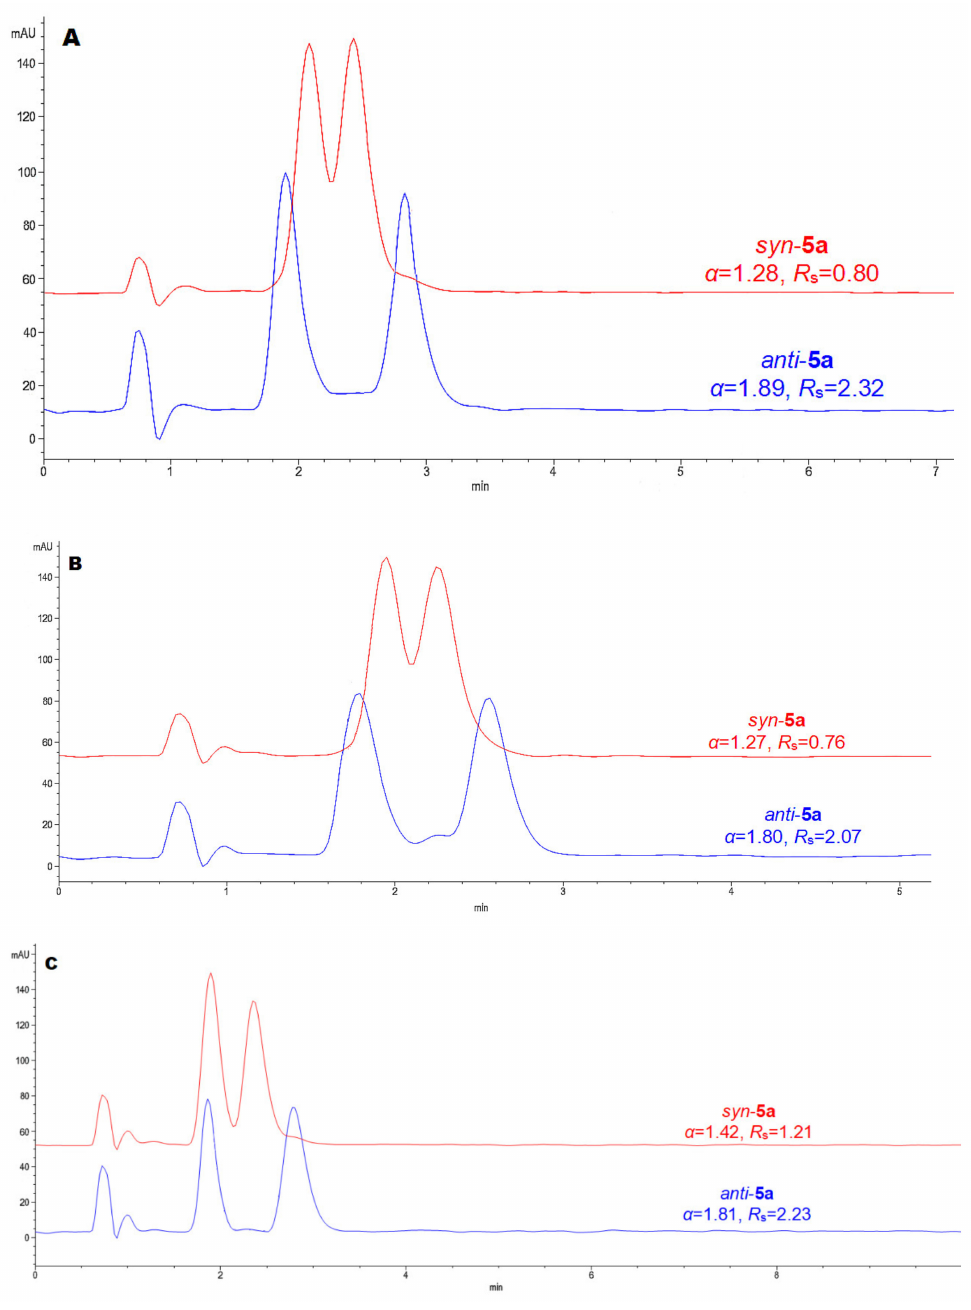
Figure 6. SFC overlay chromatograms of ( ± )- syn - 5a and ( ± )- anti - 5a on Amylose-SA column with: ( A ) CO 2 /MeOH (80/20, v / v ), ( B ) CO 2 /EtOH (80/20, v / v ) and ( C ) CO 2 /2-PrOH(80/20, v / v ) as mobile